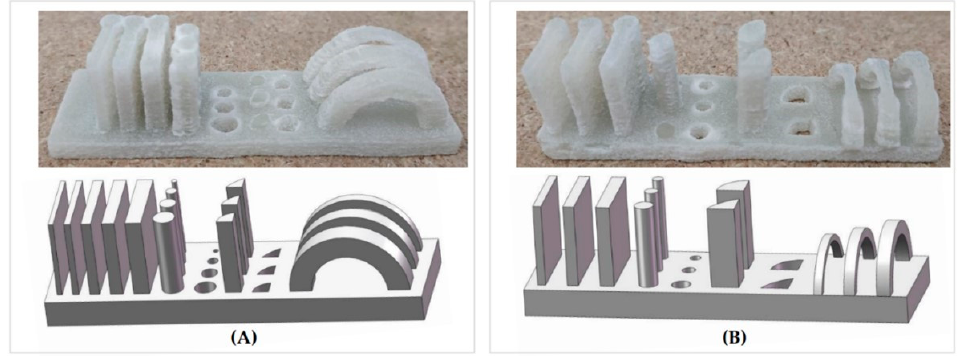
Figure 14. Produced test parts and their comparison with the theoretical CAD model. ( A ) Test part 1. ( B ) Test part 2.